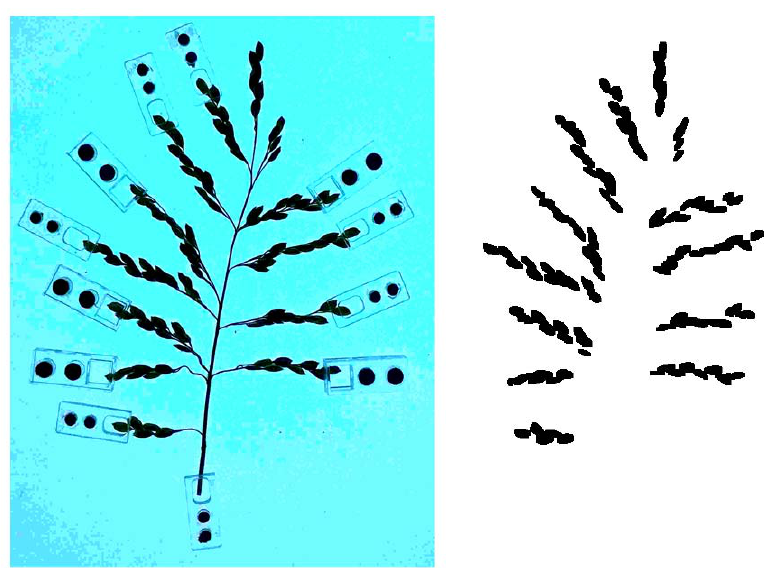
Figure 2. Image preprocessing.